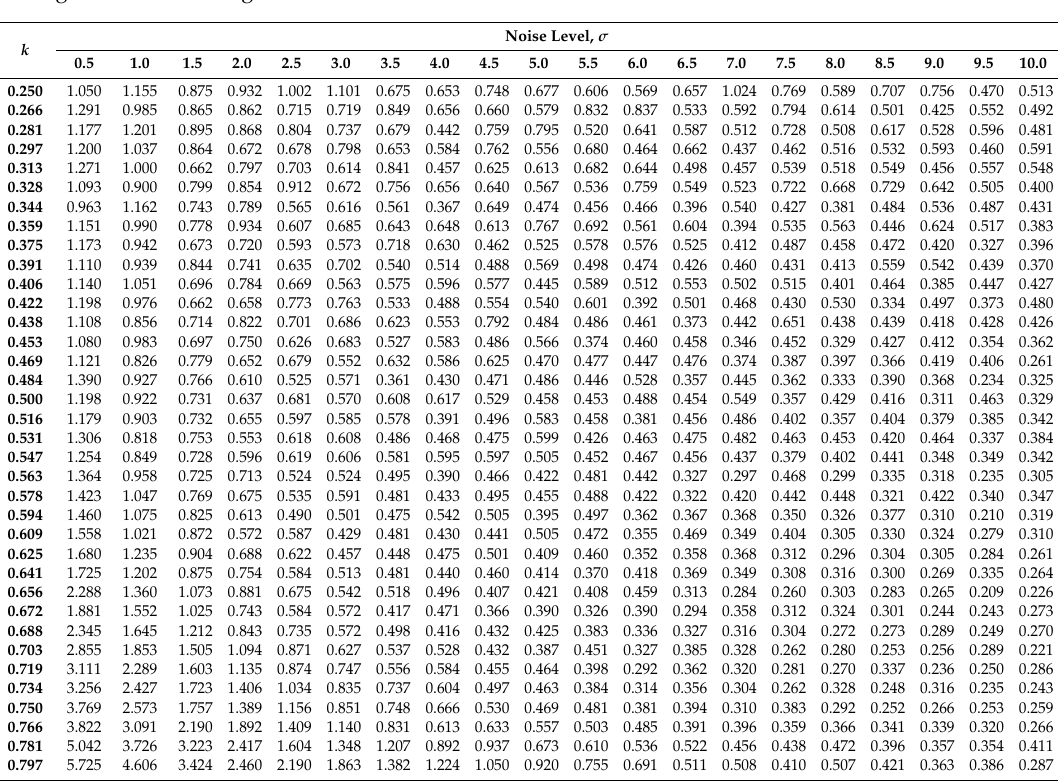
Figure S1. Standard test images used in the experiments: ( a ) Barbara; ( b ) Boat; ( c ) Cameraman; ( d ) Car; ( e ) Clown;